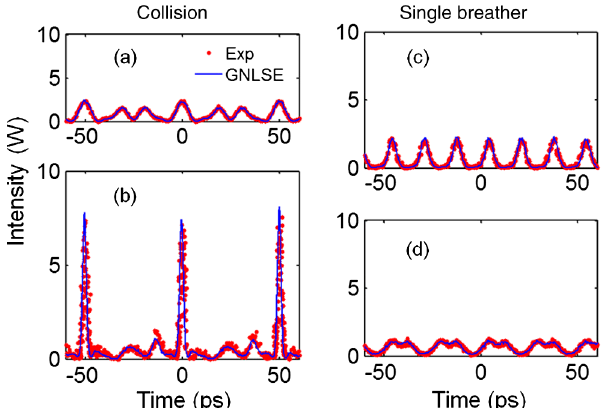
FIG. 6. Temporal intensity profiles obtained before and after propagation into the fiber. (a) Initial condition for two colliding ABs ( a 1 ¼ 0 : 14 and a 2 ¼ 0 : 34 ). (b) Giant wave emerging at 3.8 km (i.e., the collision point). (c-d) Breather profile at 3.8 km for a 1 ¼ 0 : 14 and a 2 ¼ 0 : 34 , respectively, when only one AB is excited. Experimental profiles (red points) are compared to corresponding GNLSE simulations (blue